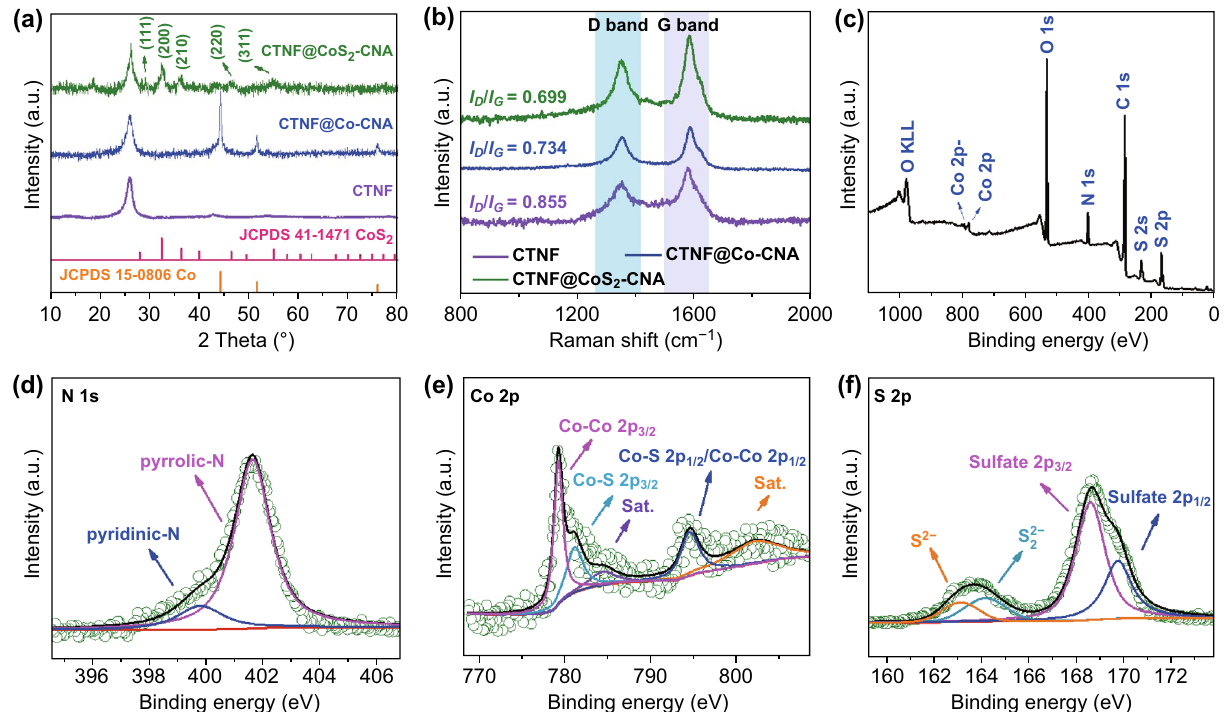
Fig. 2 a XRD patterns and b Raman spectra of CTNF, CTNF@Co–CNA, and CTNF@CoS 2 –CNA. c XPS survey spectra of CTNF@CoS 2 – CNA. High-resolution XPS spectra at d N 1 s , e Co 2 p , and f S 2 p regions of CTNF@CoS 2 –CNA